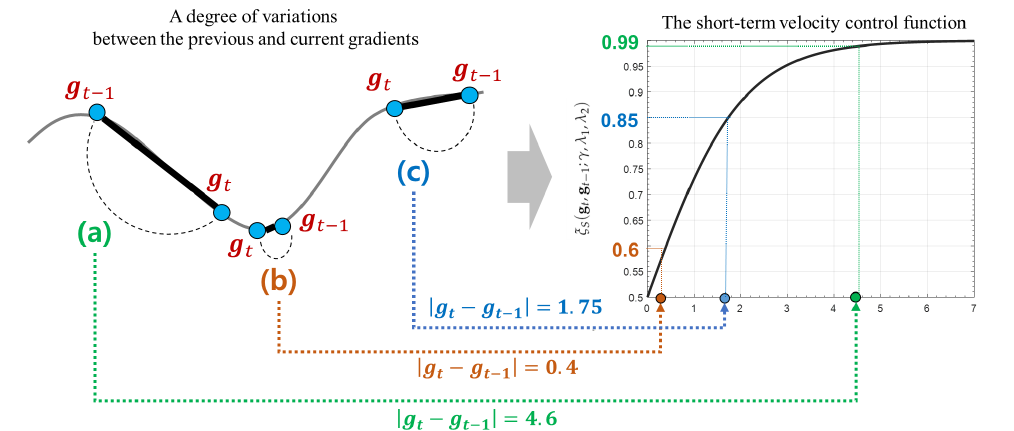
Figure 7. The principles of the short-term velocity control function. The right graph presents the plot of the short-term velocity control function described in Equation (17). ( a ) describes an example case that this function returns a value close to 1 as the difference between g t and g t − 1 becomes large. On the other hands, ( b ) shows other case that this function returns a value close to 0.5 as their difference becomes small. Finally, ( c ) illustrates how the short-term velocity control value is computed when a degree of their variation is 1.75. These examples show that this function can control the search velocity adaptively depending on a degree of variation of their previous and current